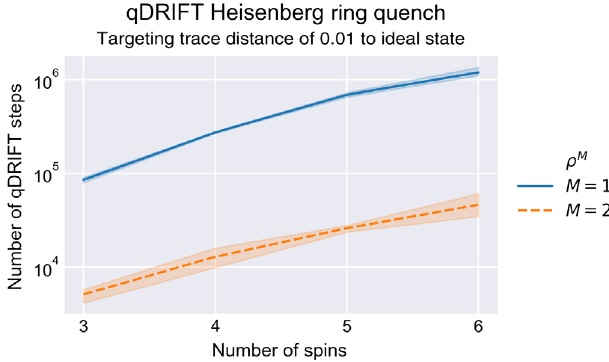
FIG. 10. qDRIFT coherent cost reduction through virtual distillation in the Heisenberg model. Here we show the number of coherent qDRIFT steps required to reach a target trace distance, with and without virtual distillation using two copies. We see that there is a consistent reduction of at least 16 × in the number of required steps. When accounting for the overhead of using two copies, this amounts to an 8 × reduction in the coherent space-time volume used to reach the same error